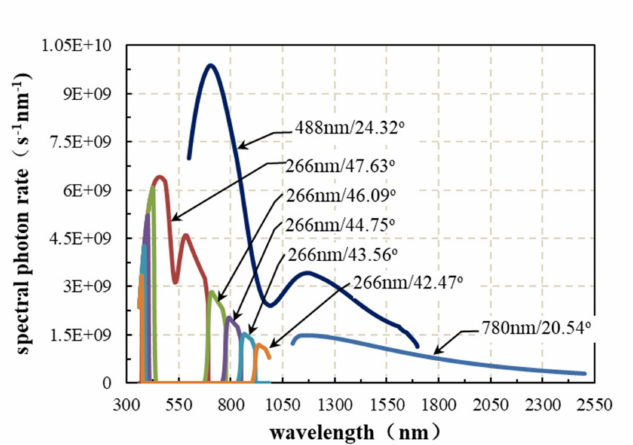
Figure 2. Spectral photon rates of correlated photons generated in seven barium metaborate, β -BaB 2 O 4 ), (BBO) crystals pumped by three lasers at 266, 488 and 780 nm. Phase matching conditions are optimized to cover a spectrum of 380–2500 nm with photon rates higher than 10 8 s − 1 nm − 1 and photon exit angles less than 6 ◦ . Numbers in legends represent pump wavelength / phase-matching